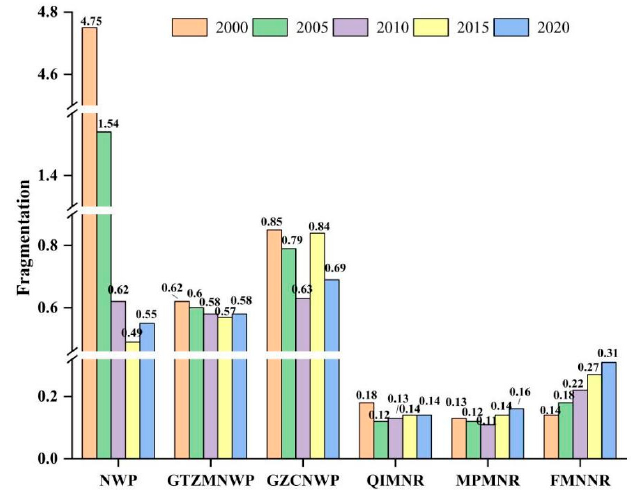
Figure 7. Fragmentation change of mangrove forests for nature reserves from 2000 to 2020.